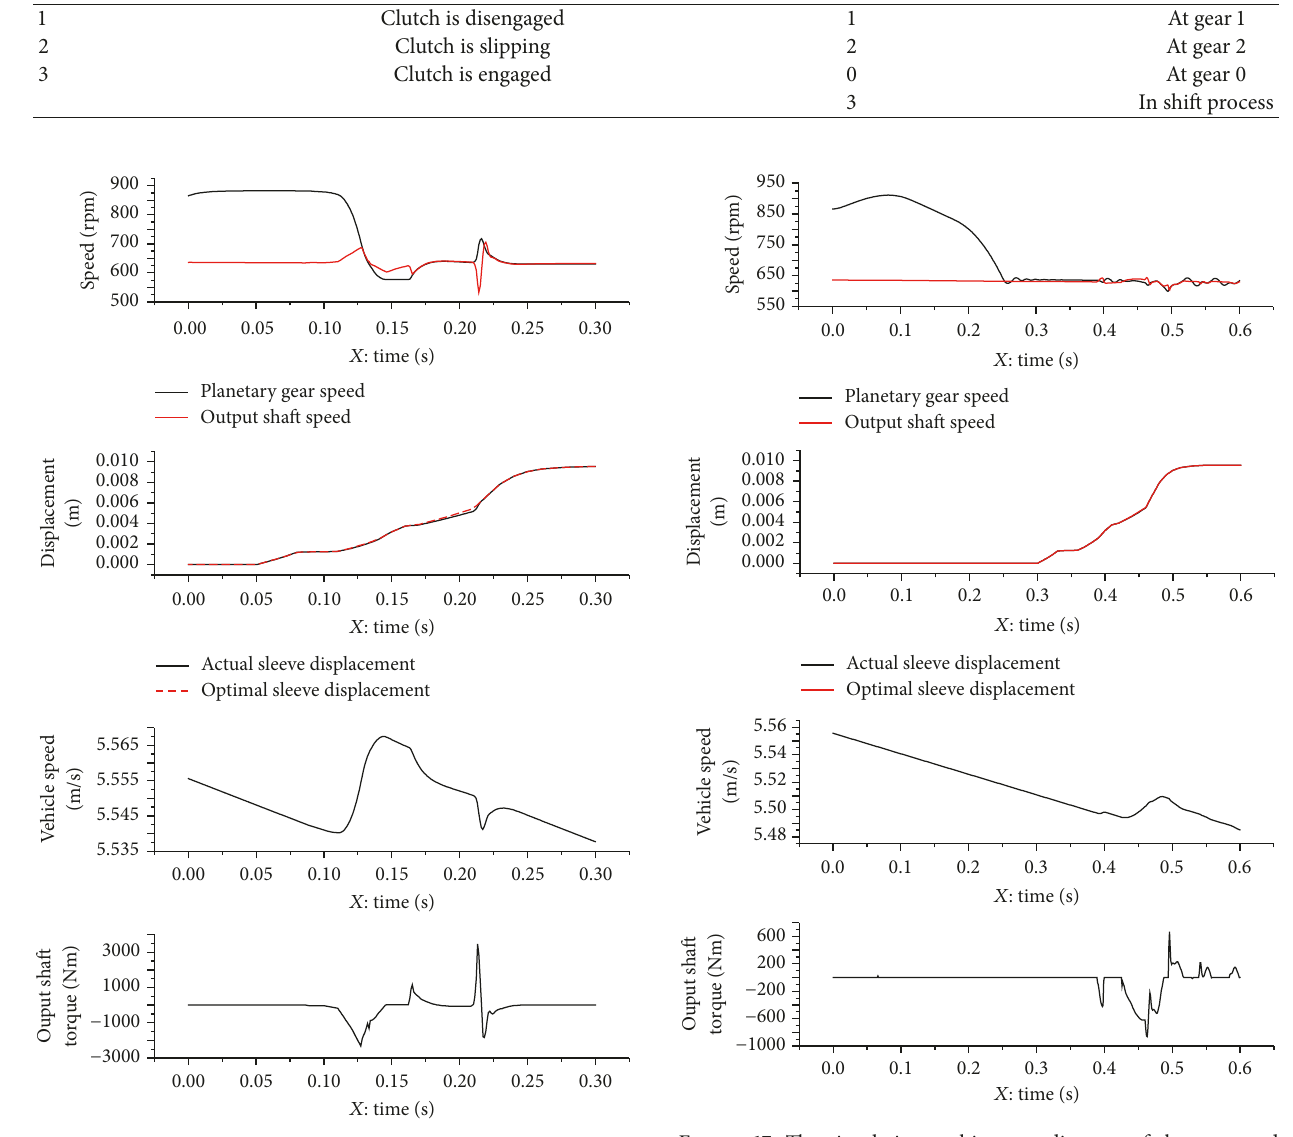
Figure 16: The simulation results of the normal method without speed regulation.